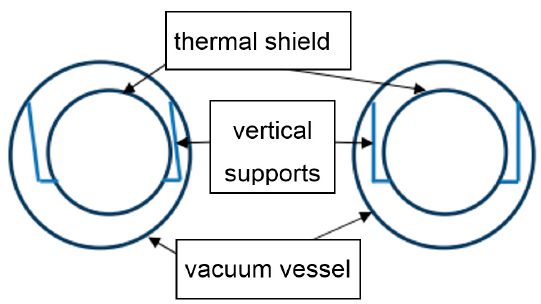
Figure 6. The floating support system of the thermal shield: displaced thermal shield ( left ); centered thermal shield ( right ). The lateral displacement is exaggerated for clarity.